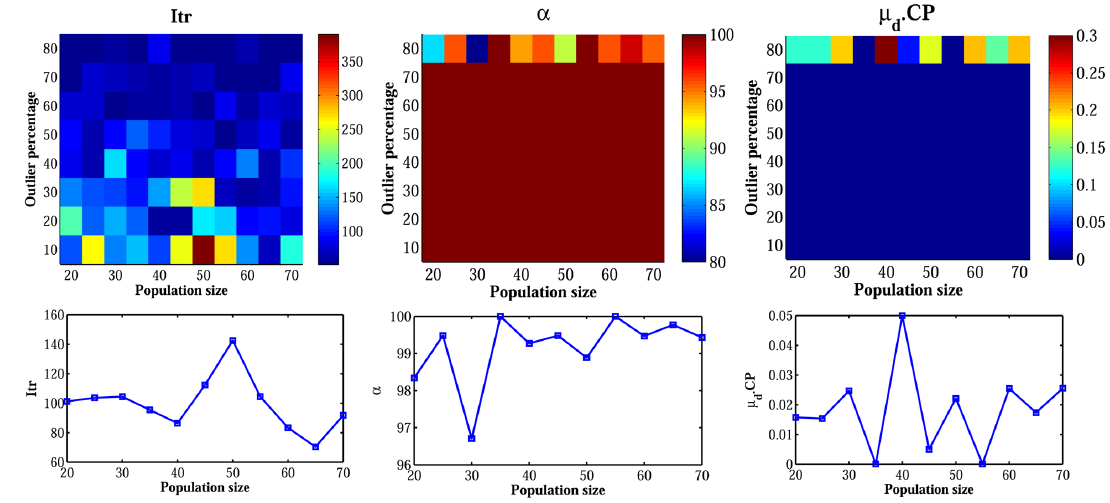
Figure 10. Performance of the proposed algorithm with varying GA population size. The graph at the bottom of each surface-plot represents the average of the respective performance criterion versus the population